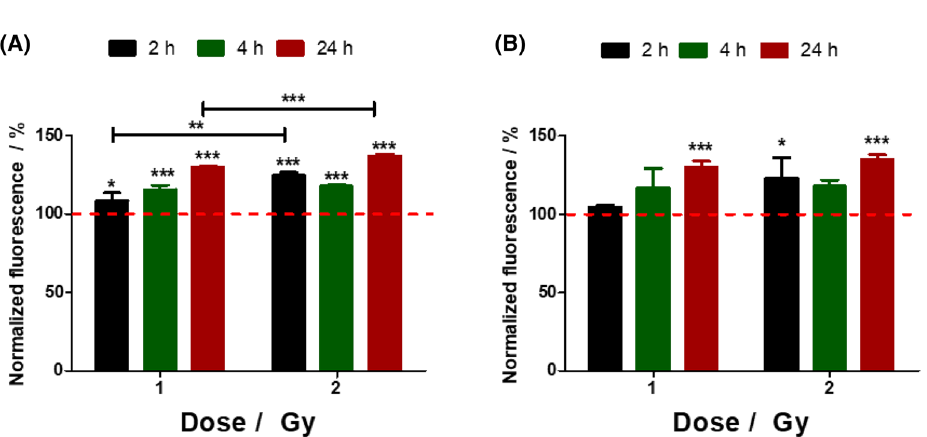
Figure 2. Scanning electron microscopy images of B16 cells grown 24 h on gold surface obtained at different magnifications and using signals from different detectors (SE2 and InLens): ( A ) 300×; ( B ) and ( C ) 500×.